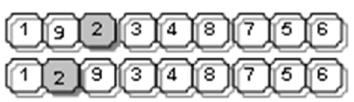
Figure 9. The LOX procedure.